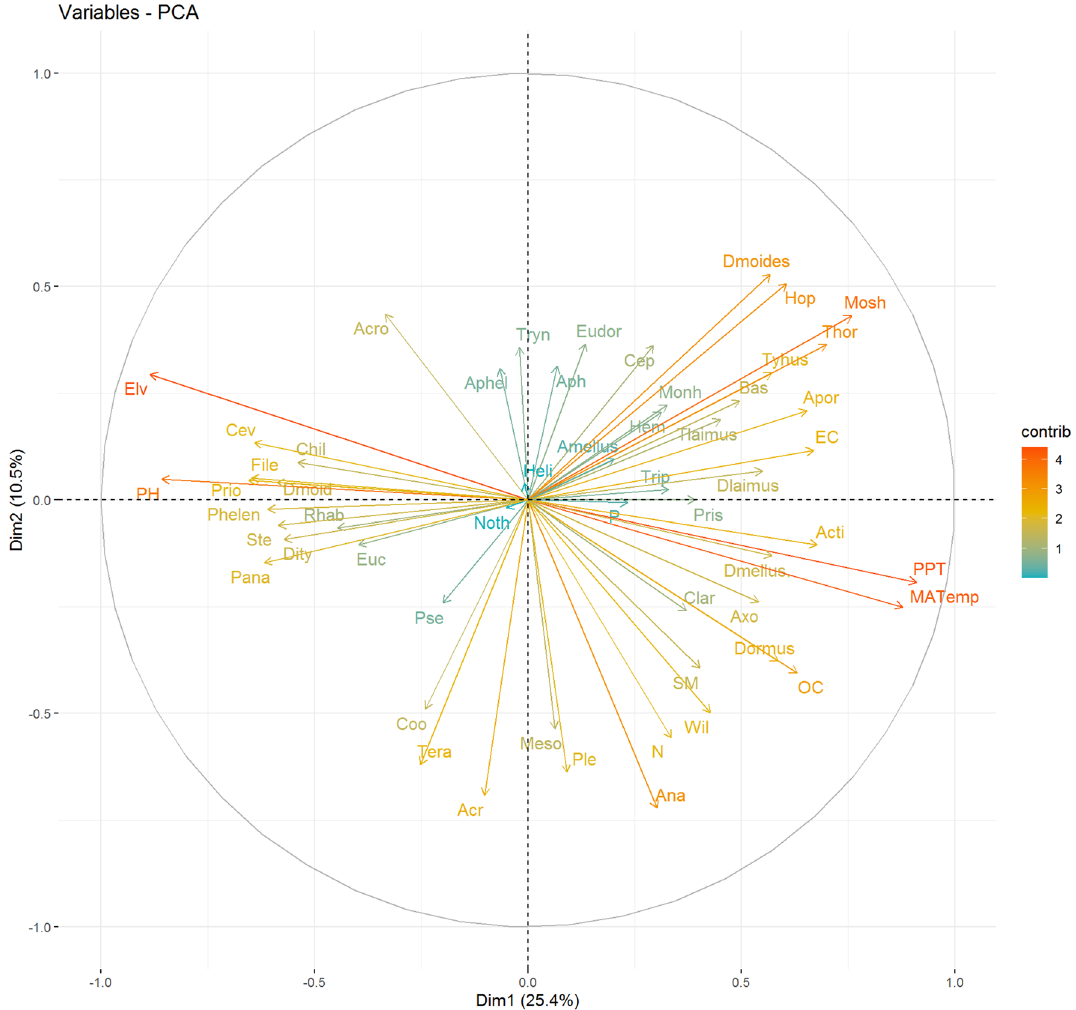
Figure 7. Principal Component Analysis (PCA) of soil Nematode genera trophic groups and soil attributes along elevation. Soil variables elevation trophic group and nematode genera are marked by arrows. Percentage of variance explained was 23.5% and 10.7% for Dim 1 and Dim 2